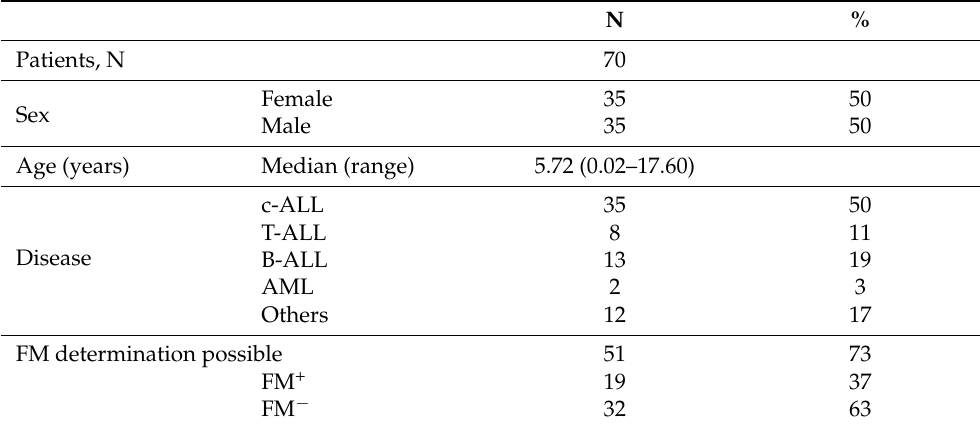
Table 1. Patient characteristics. Others include: T cell non-Hodgkin lymphoma (T-NHL), neurob- lastoma (NB), hemophagocytic lymphohistiocytosis (HLH), mucopolysaccharidosis type I (MPSI), and Immune dysregulation polyendocrinopathy enteropathy X-linked syndrome (IPEX). c-ALLs are a subgroup of B-ALLs and considered separately. Depicted are counts and frequencies in the subgroups. FM determination was performed using